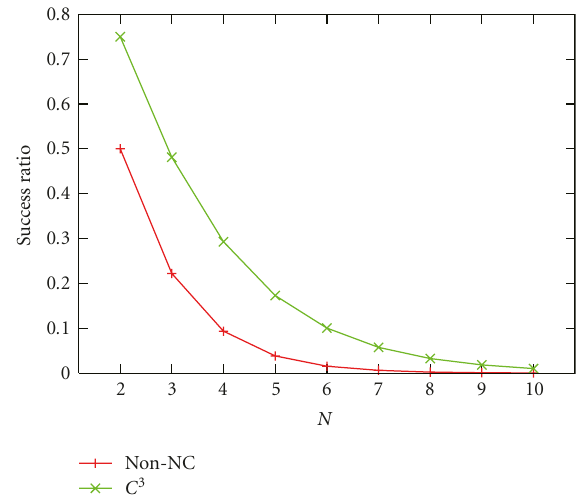
Figure 4: Success ratio as a function of N (in default value M = N and B =